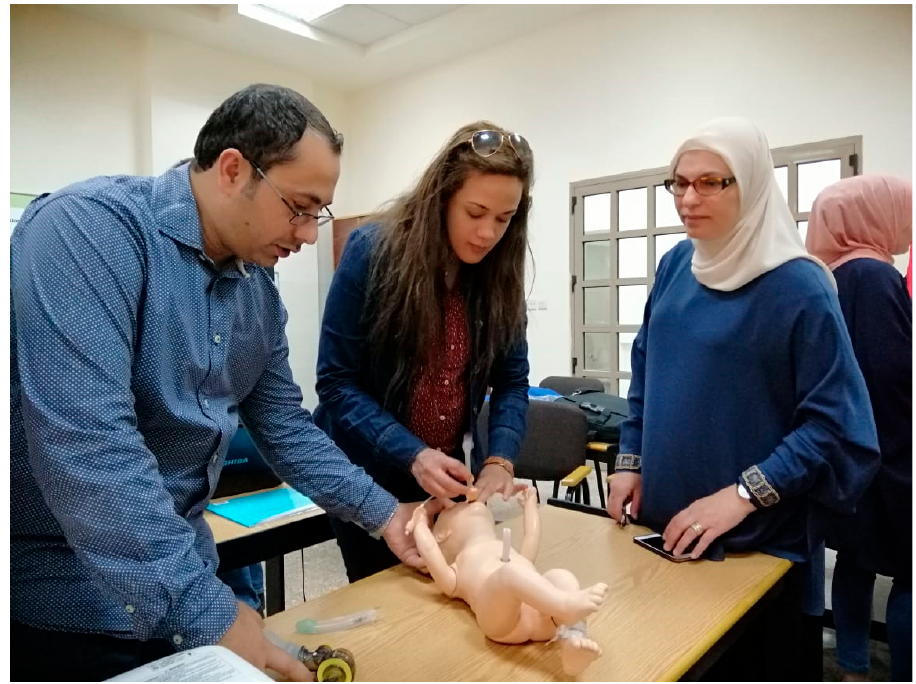
Figure 1. Al Bashir SALSA workshop used to educate providers on the technique.